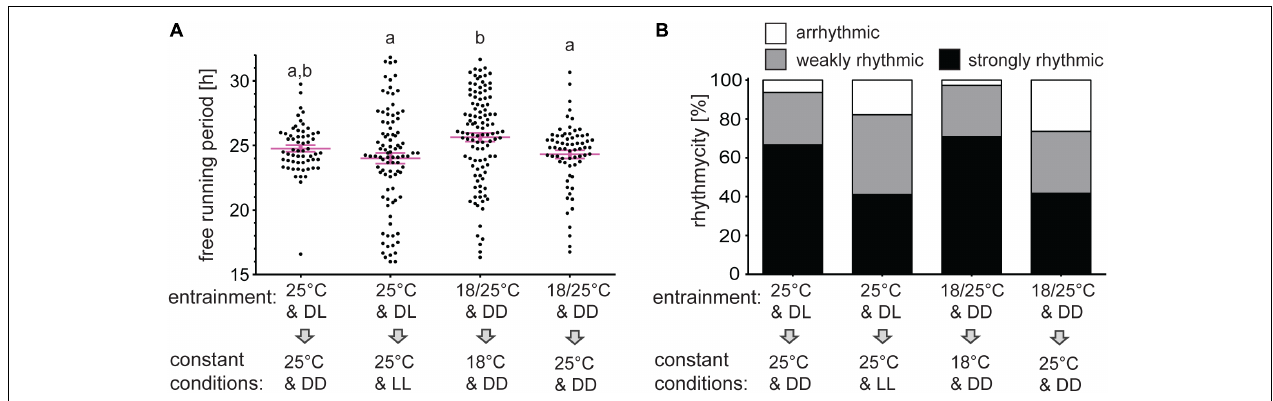
FIGURE 6 | Rhythmicity in constant “day” conditions is lower than in constant “night” conditions. Adult males were entrained for 5 days in long photoperiod regime D6:L18 at 25 ◦ C and released to DD or LL at 25 ◦ C. The second group of males was entrained to long thermoperiod 18 ◦ C/25 ◦ C in DD and then released to constant cryophase of 18 ◦ C or constant thermophase of 25 ◦ C. The percent of rhythmic males (B) and the free-running period (A) differ between groups. The different small letter above categories indicates statistical difference p < 0.01 (Kruskal–Wallis test with Dunn’s post hoc test).